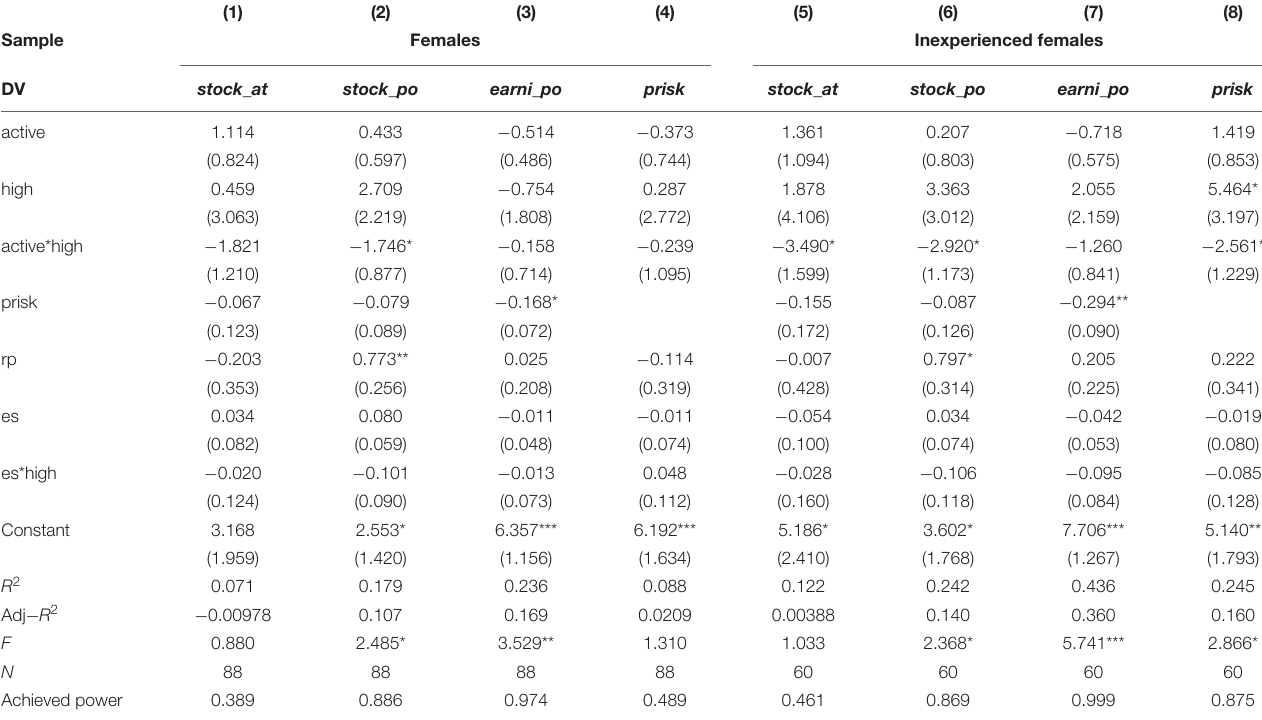
The dependent variables are as follows: stock_at represents the attractiveness of Company X’s stock as a medium- to long-term investment; stock_po represents the potential of Company X’s stock price to appreciate over the next 3 years; earni_po represents Company X’s earnings potential over the next 3 years; and prisk represents perceived risk. Active = 1 if receiving active stimulation and =0 otherwise; high = 1 if the pay ratio is high and =0 otherwise; rp represents risk preference; and es represents equity sensitivity. The standard errors are shown in parentheses. The asterisks indicate significant differences (* 0.1,** 0.01, ***